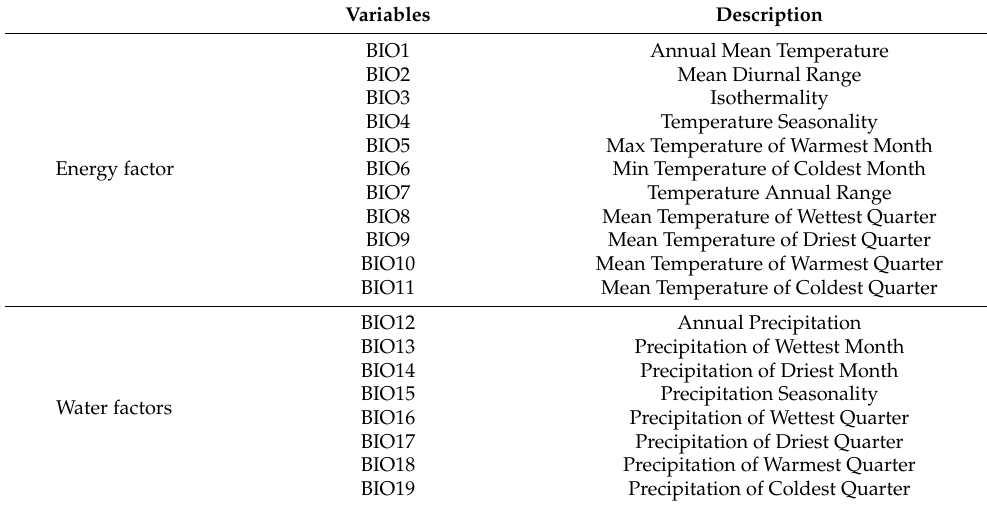
Table 2. Nineteen Worldclim Bioclim variables used to test the water–energy dynamics